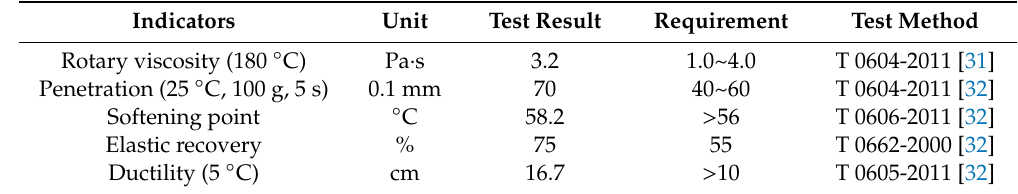
Table 2. Technical indicators of asphalt-rubber binder.